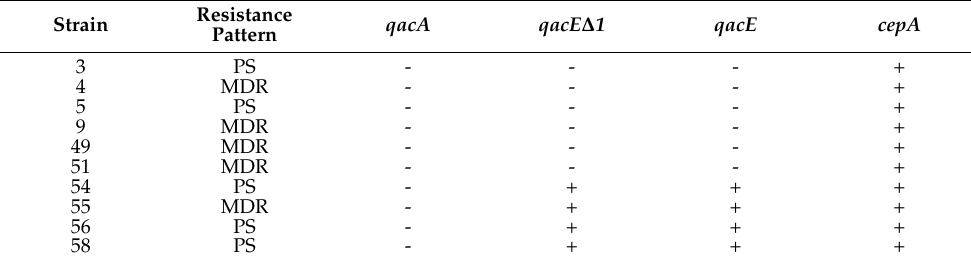
Table 1. Distribution of known microbicide-resistance genes among A. baumannii